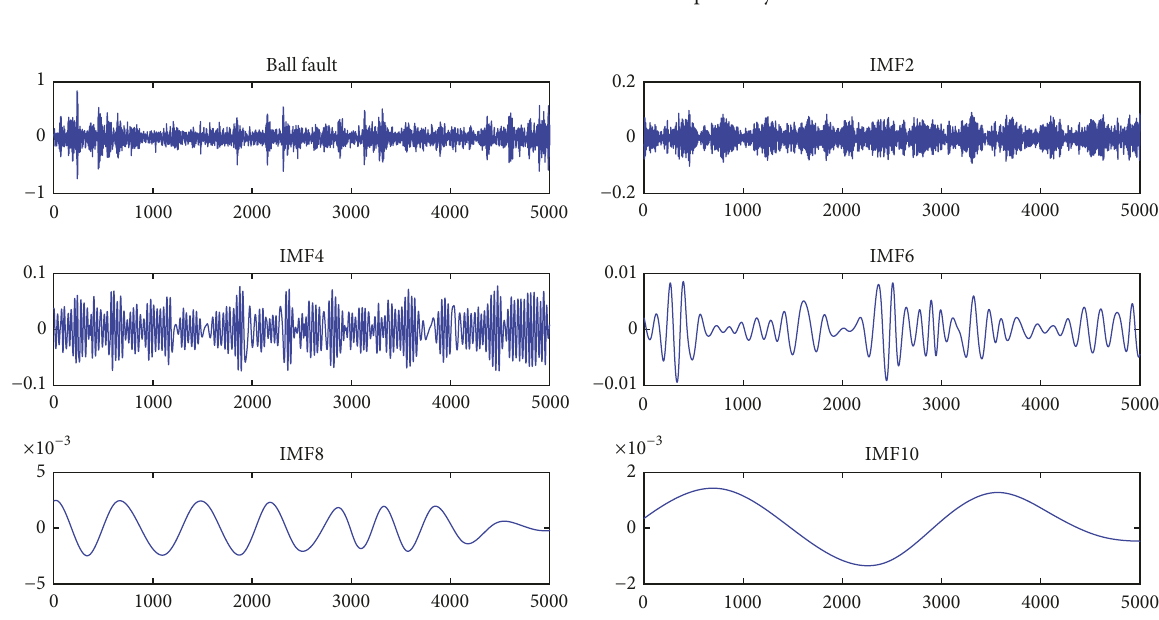
Figure 5: Partial IMFs of DEBall decomposed by